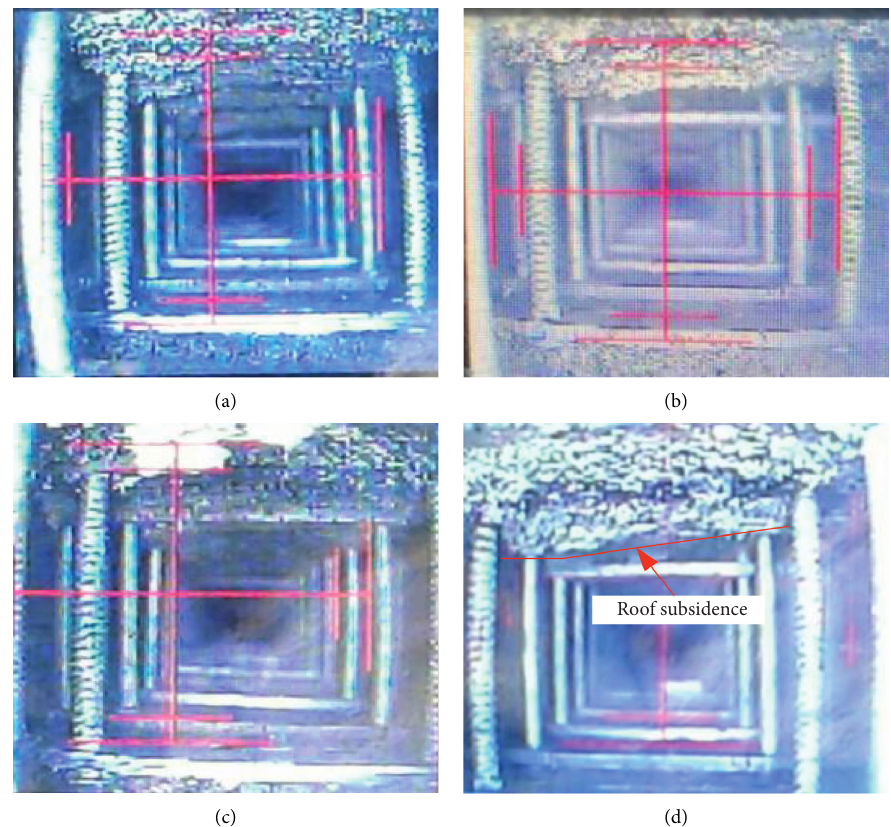
Figure 9: Roadway surrounding rock deformation at different forward distances. Coal seam excavation: (a) 0 m; (b) 20m; (c) 45m; (d) 80m.